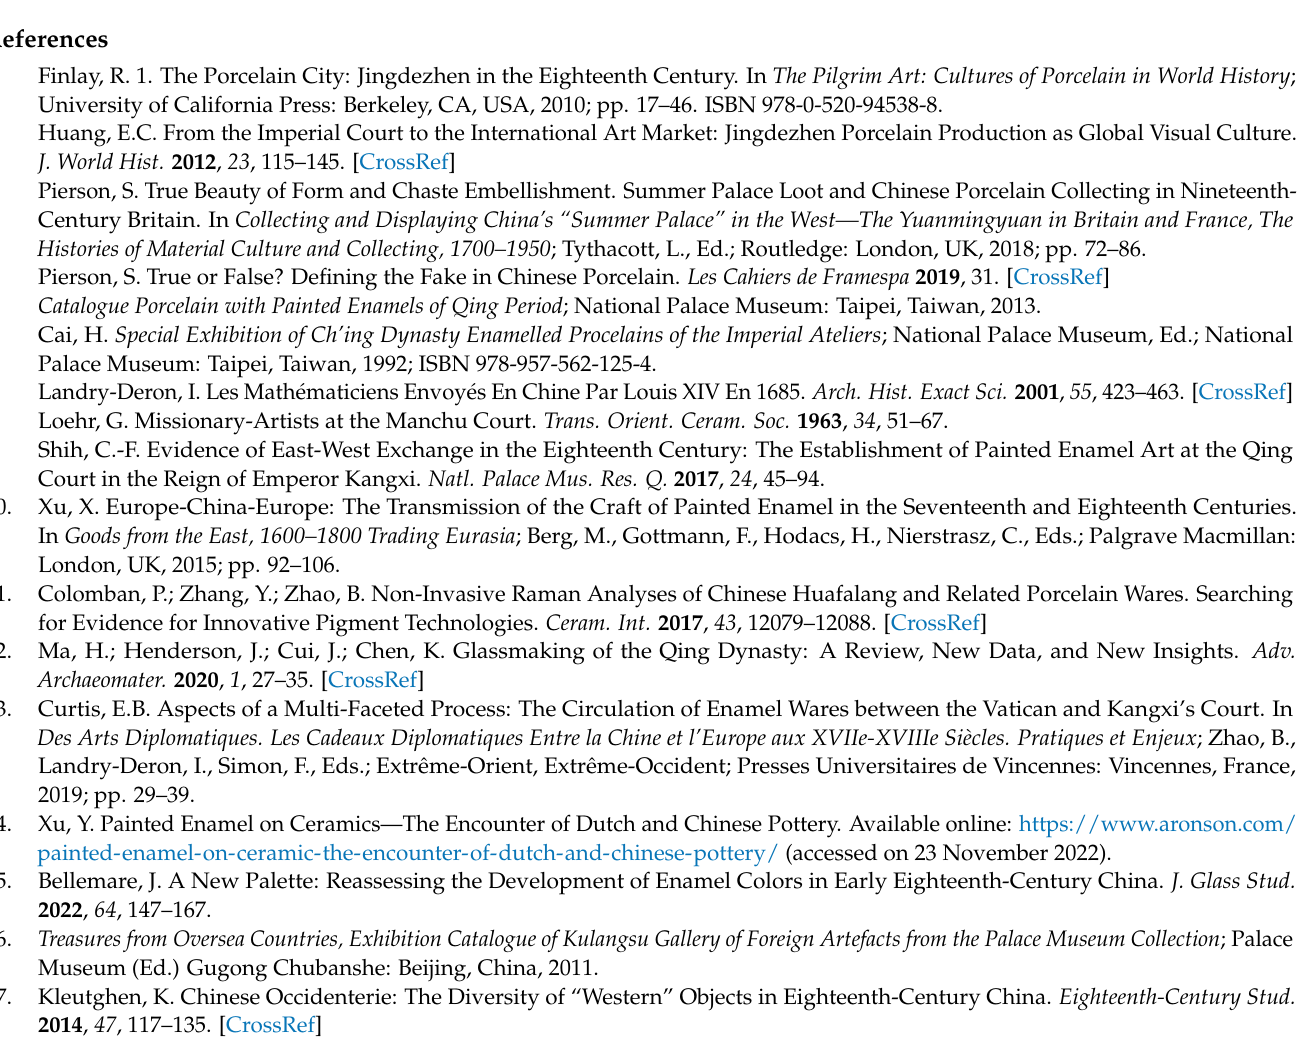
XRF spectra. Table S1: XRF data. Table S2: Details of the calculations of the mean, standard deviation and difference obtained from the normalized areas of some element of QL